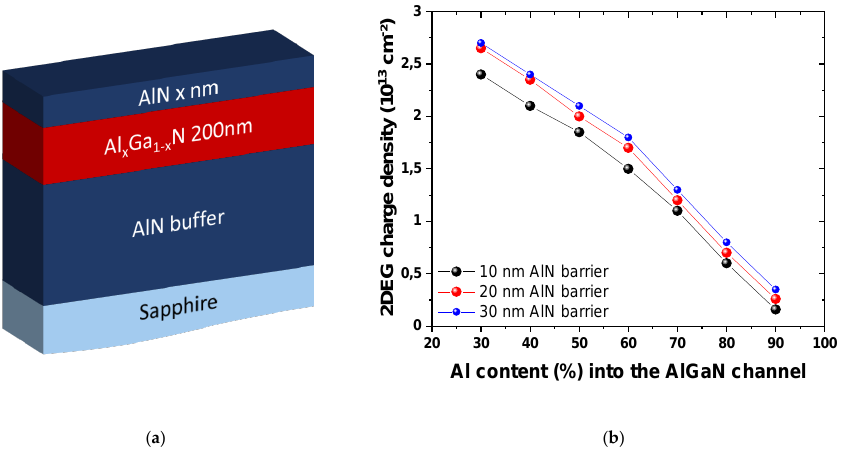
Figure 1. Schematic cross section of the simulated AlN/AlGaN/AlN heterostructure ( a ) and 2DEG charge density dependence on the Al content in the AlGaN channel ( b ).